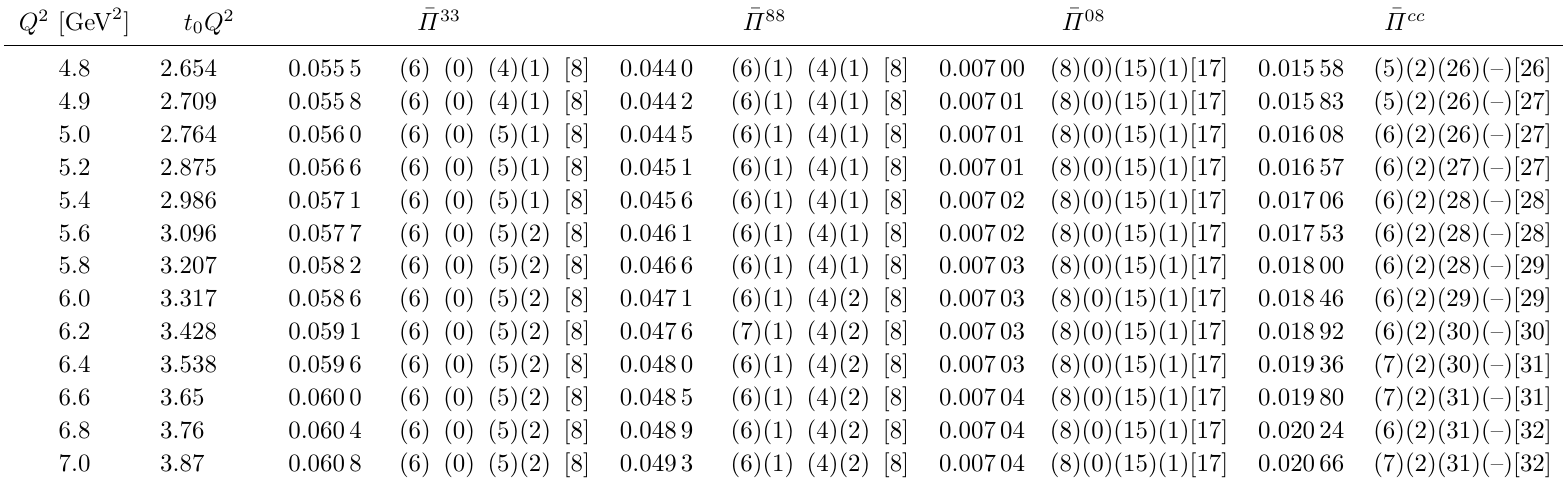
Table 12 . Results for the ¯ Π 33 , ¯ Π 88 , ¯ Π 08 and ¯ Π cc HVP contribution extrapolated to the physical point for all the values of Q 2 sampled. The first quoted uncertainty is the statistical error, the second is the systematic error from varying the fit model estimated in section 4.1.1, the third is the scale-setting error (see section 4.2.1), and the fourth is the systematic from missing charm sea-quark loops (see section 4.2.2). The final uncertainty, quoted in square brackets, is the combination of the previous